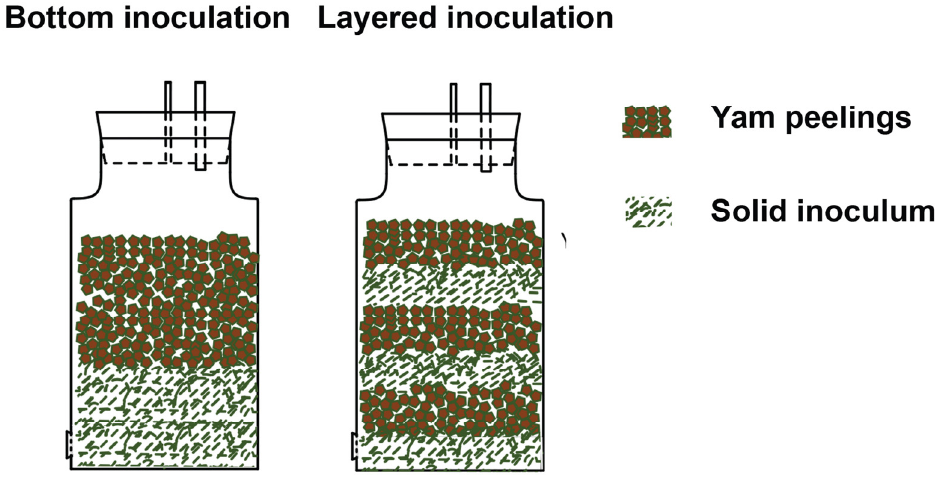
Figure 1. Bottom inoculation and multi-layered inoculation in the SSAD